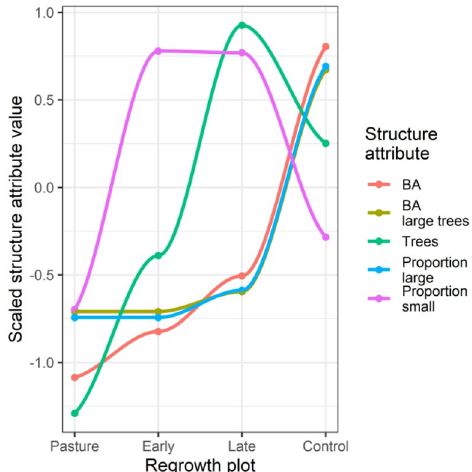
Figure 1. Forest structure changes across a lowland forest regrowth gradient. Showing mean values of five forest structure attributes recorded in 30 plots (15 control and 15 regrowth). Regrowth plot shows differences between control, late second-regrowth, early second-regrowth and pasture plots. Values are scaled (centered and scaled by the standard deviation) to enable simultaneous visual comparison of the different attributes. The lines are from LOESS smoothing as guides to aid visual interpretation.